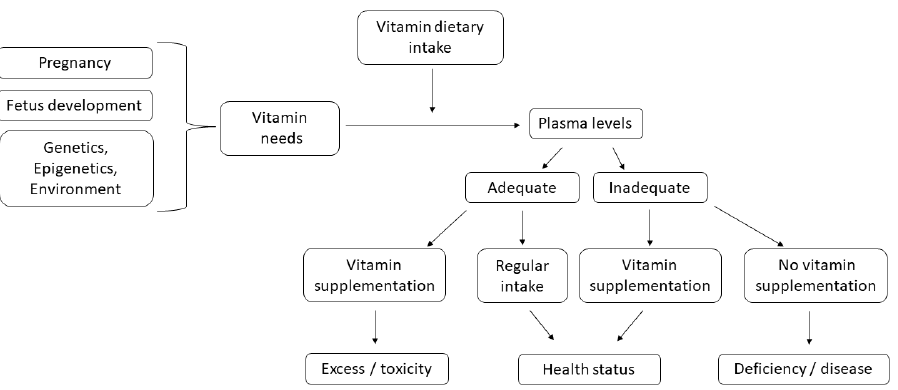
Figure 1. Flow chart to explore how individual susceptibility affects pregnancy health and outcomes. Vitamins must be ingested through diet or supplements and much attention should be paid to their adequate intake, which should be established as function of real